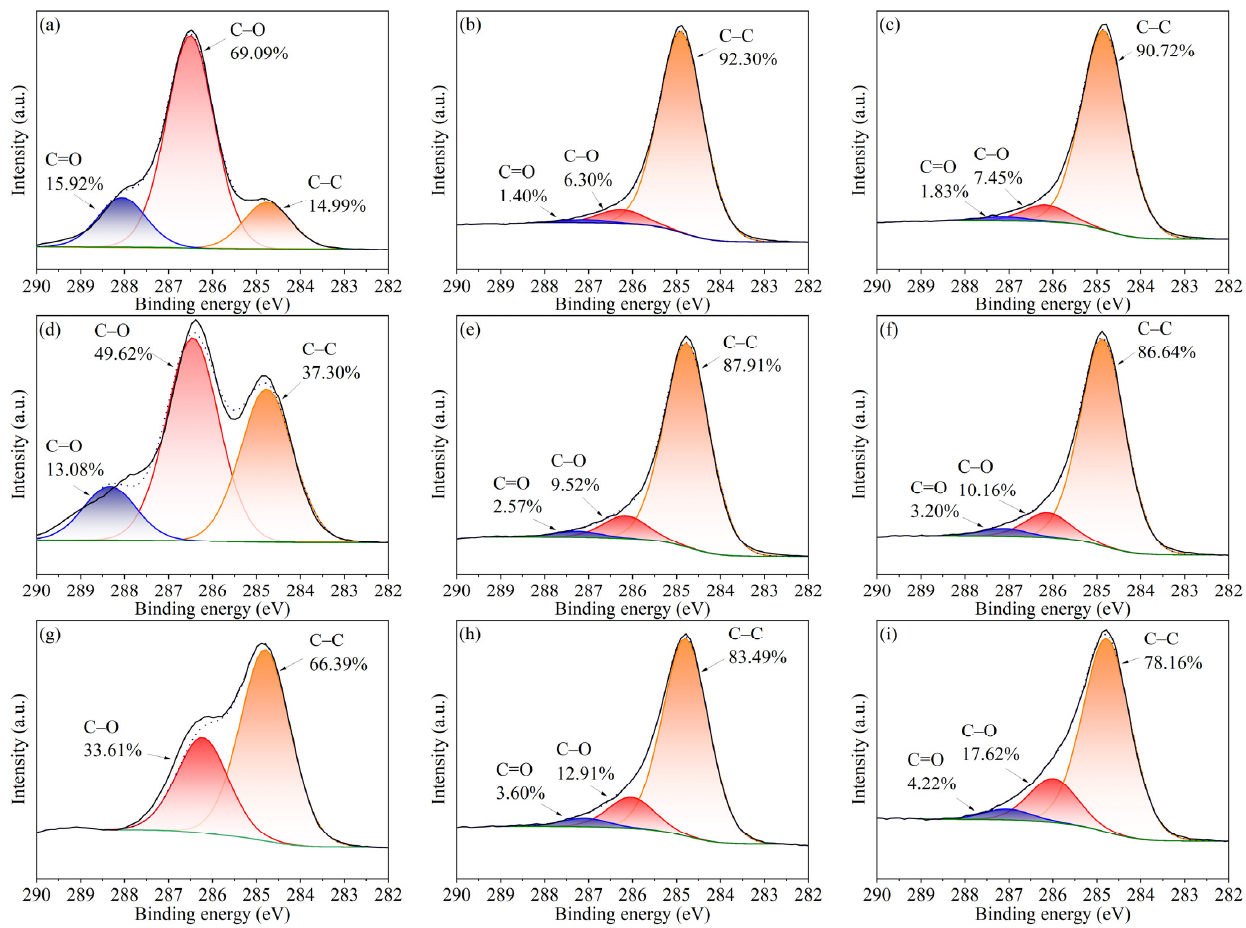
Figure 5. XPS spectra (C1 s) of three model components and their pyrolysis residue. ( a ) CE; ( b ) RCE; ( c ) RCE-5%Cd; ( d ) XY; ( e ) RXY; ( f ) RXY-5%Cd; ( g ) LG; ( h ) RLG; ( i ) RLG-5%Cd. RCE, RXY, and RLG represent the pyrolysis residue of cellulose, xylan, and lignin, respectively. RCE-5%Cd, RXY-5%Cd, and RLG-5%Cd represent the pyrolysis residue of Cd-concentrated cellulose, xylan, and lignin, respectively. Table 2. C, H, and O content in pyrolysis residue of three model